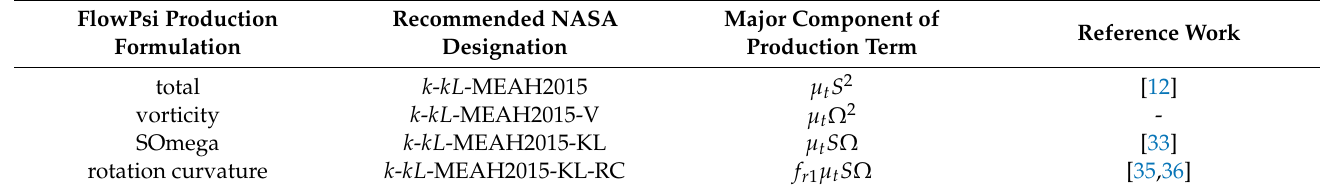
Table 2. Turbulent production formulation and vorticity correction